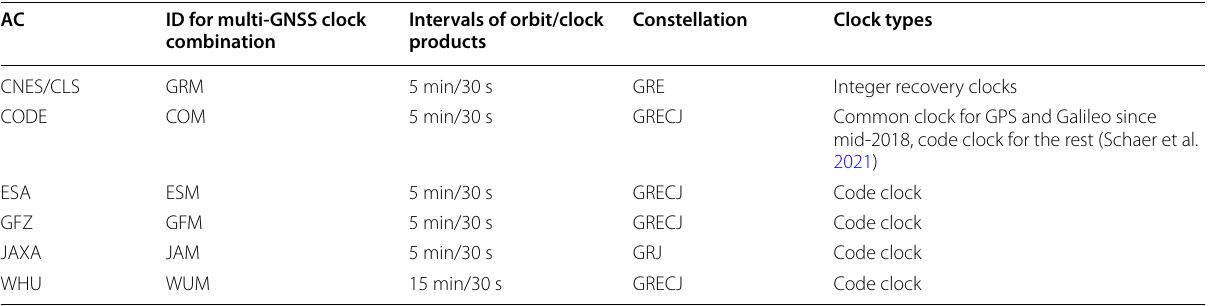
Table 1 Overview of orbit and clock products from the selected ACs for clock combination. ‘G’ ‘R’, ‘C’, ‘E’, and ‘J’ in the fourth column indicate GPS, GLONASS, BDS, Galileo and QZSS, respectively